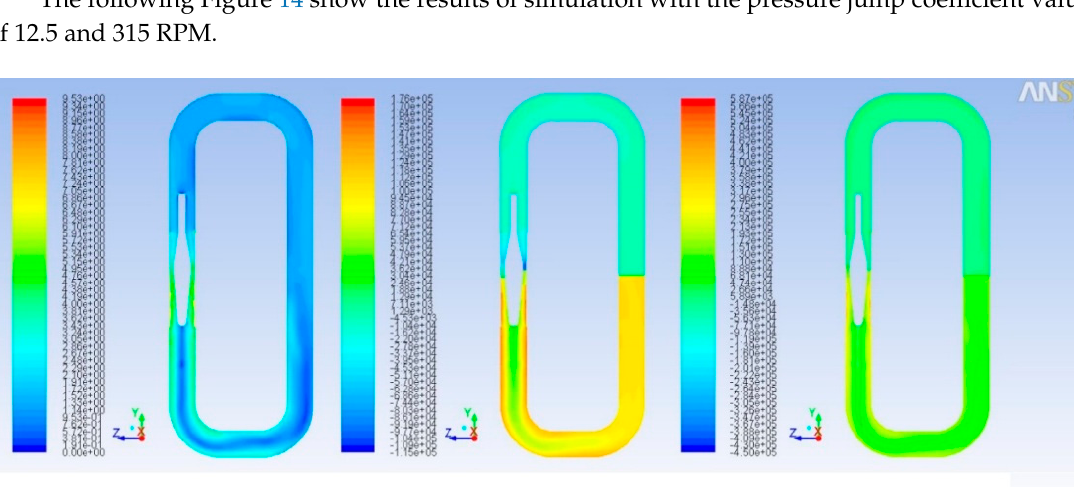
Figure 14. Loop simulation: velocity contours ( Left ), static pressure contours ( Middle ) and total pressure contours ( Right ) on a longitudinal plane.